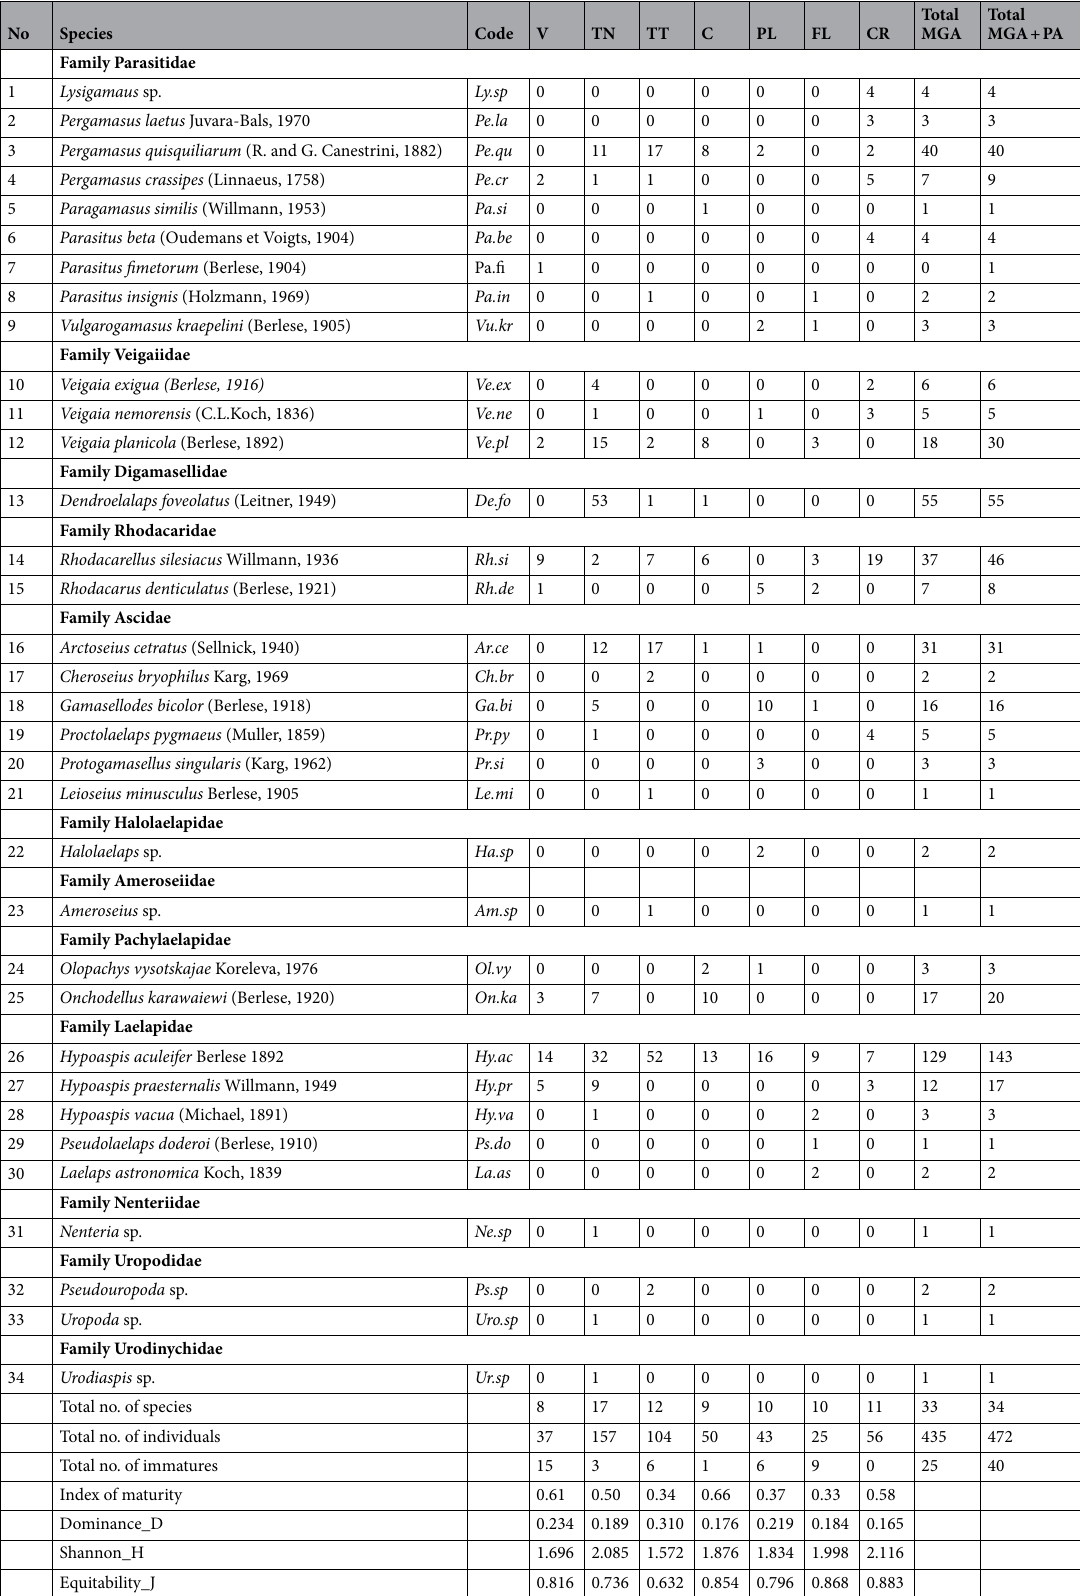
Table 3. Numerical abundance of Mesostigmata mites from MGA areas (including the urban protected area-V) in Bucharest,